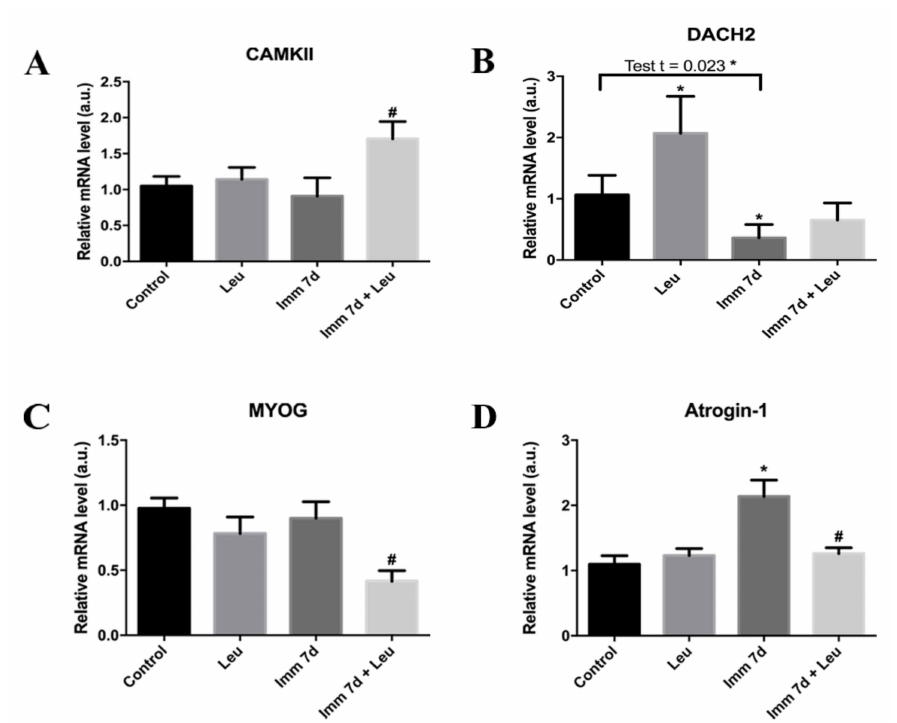
Figure 6. E ff ect of leucine on the HDAC4 canonical pathway. CAMKII , DACH2 , MYOG , and atrogin-1 mRNA levels ( A – D , respectively) were determined by qPCR 7 days after immobilization in leucine supplemented, immobilized, and immobilized leucine supplemented groups ( n = 5–8 per group, two independent experiments were performed). Cyclophilin A expression was used as housekeeping gene. Data are expressed as mean ± SEM. Statistical analysis included one-way ANOVA followed by Tukey’s posthoc test. * p < 0.05 vs. control group; # p < 0.05 vs. immobilized 7 d